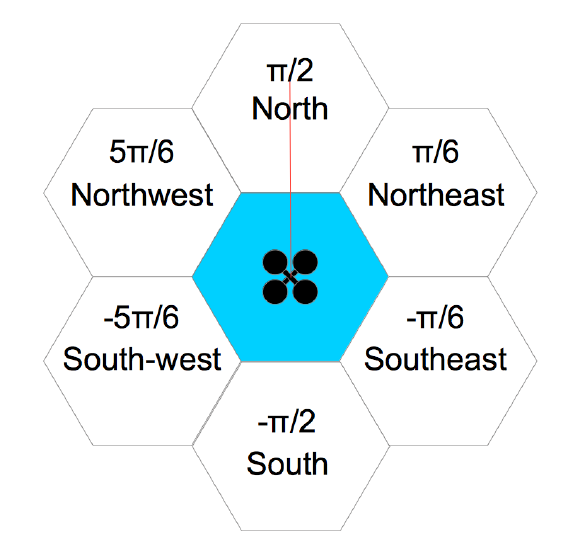
Figure 1. Unmanned Aerial Vehicle (UAV) in hexagon